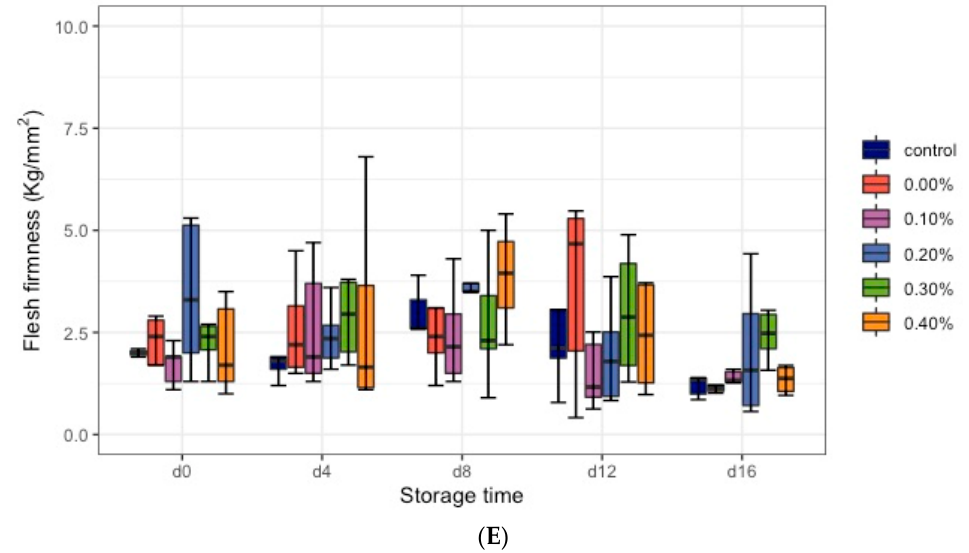
Figure 6. The pH value ( A ), titratable acidity ( B ), anthocyanin content ( C ), pericarp puncture strength ( D ), and average flesh firmness ( E ) of blueberry during Figure 5. Weight loss and decay rates of blueberry under different treatments. Control represents the untreated blueberries.